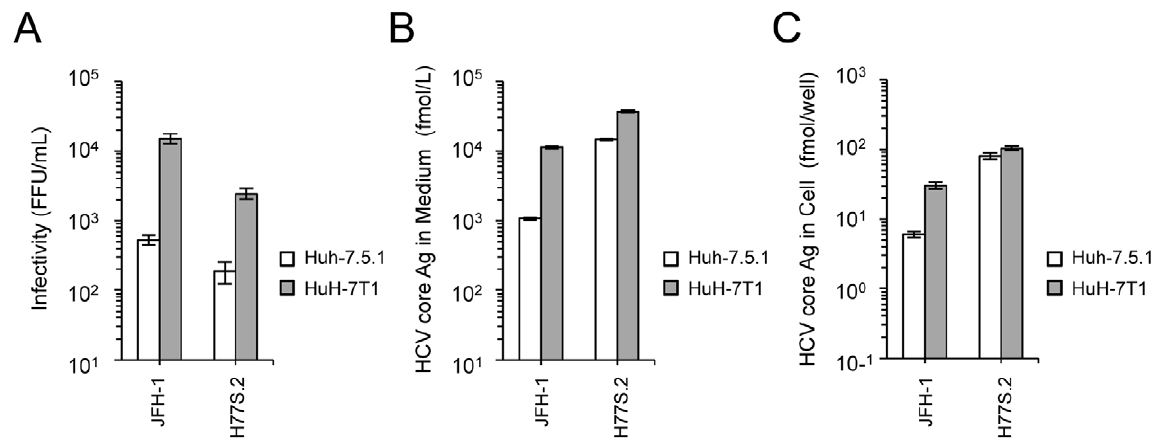
Figure 5. Infectious virus production of H77S.2 in HuH-7T1 and Huh-7.5.1. Two micrograms of JFH-1 RNA or 10 micrograms of H77S.2 RNA were electroporated into Huh-7.5.1 and HuH-7T1. Culture medium and cells were harvested at Day 3, and infectivity titer and HCV core level were determined.